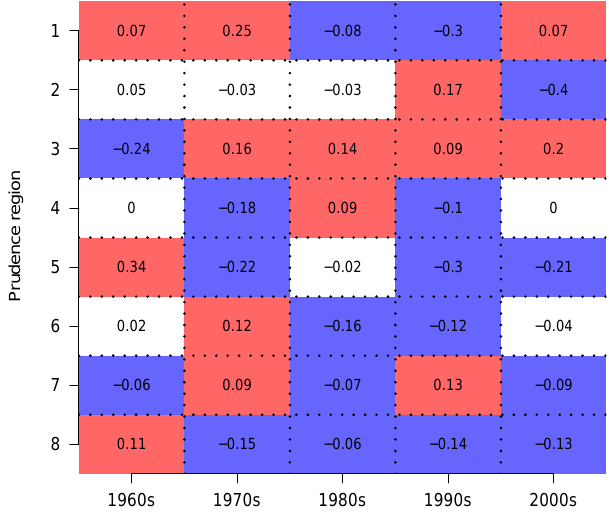
Figure 8. Differences between the two right panels of Fig. 7. Blue: network approach performs better, red: standard approach performs better, white: tie.